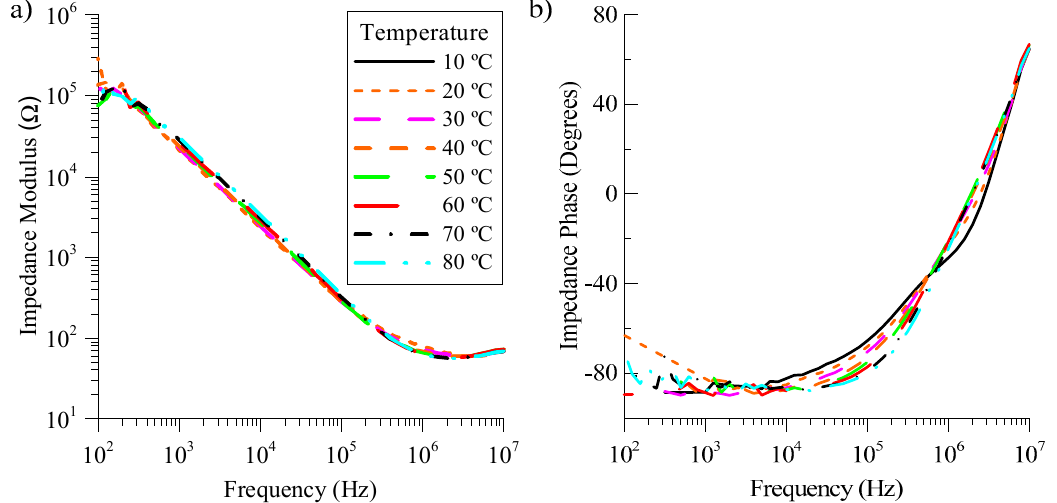
Figure 3. Magnitude ( a ) and phase ( b ) of the impedance of a nematic liquid crystal cell (NCL) as a function of the frequency of the external voltage signal for several temperatures of the environment.